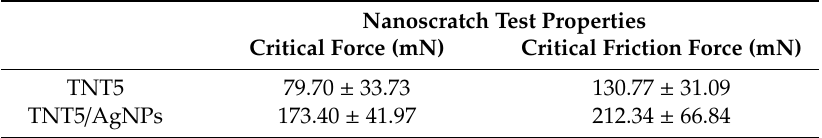
Table 5. Adhesion properties of the titanium dioxide nanocoatings to the titanium alloy